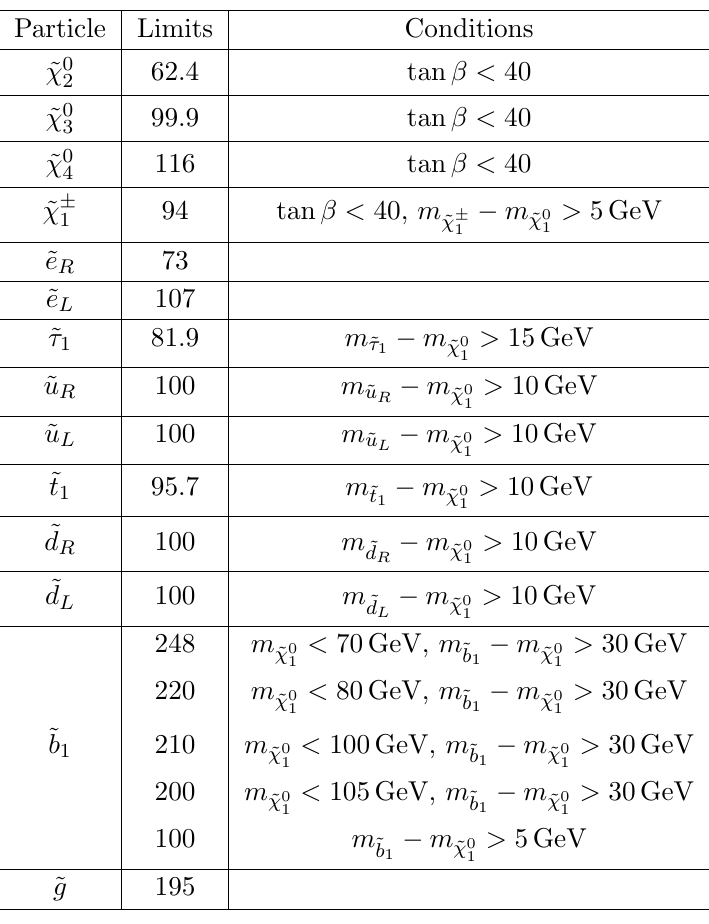
Table 4 . Constraints on the SUSY particle masses (in GeV) from searches at LEP and the Tevatron